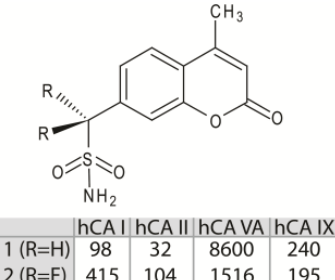
Figure 2. Chemical structures of compounds 1 and 2 . K I value (nM) of these molecules against hCA I, II, VA and IX are reported [23].